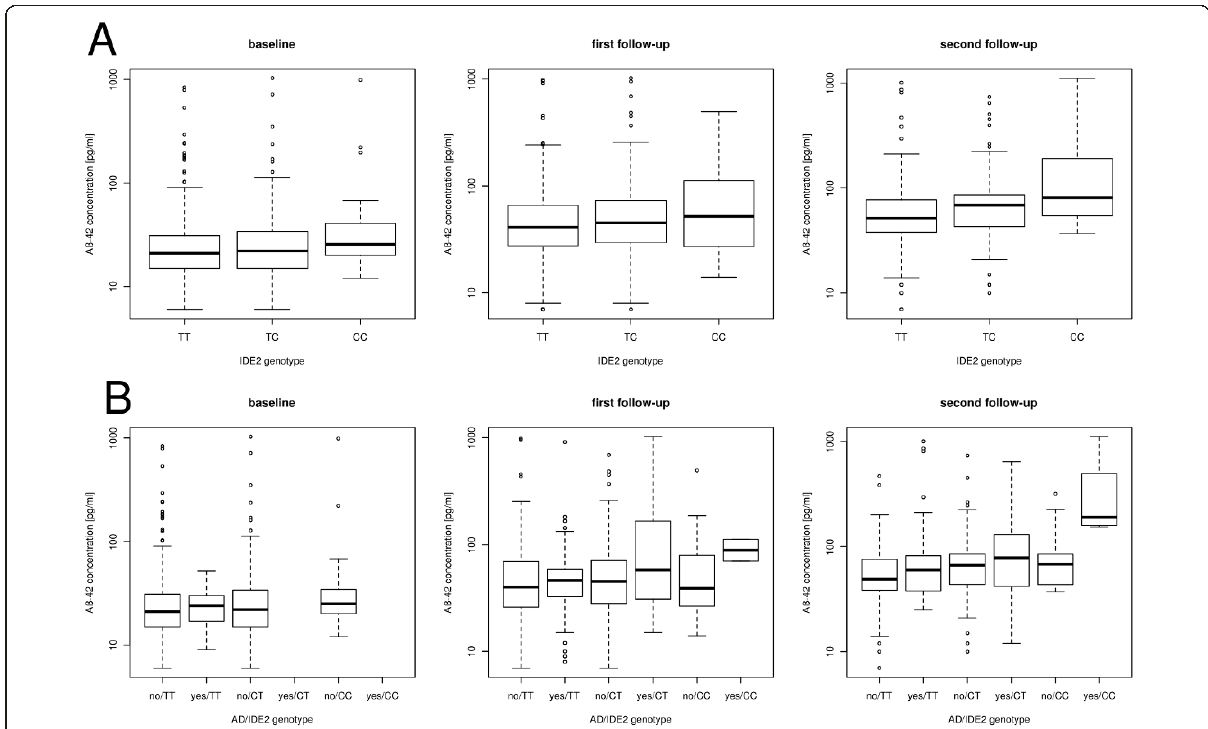
Table 4 Interaction analysis of insulin degrading enzyme 2 (SNP rs4646953) genotype